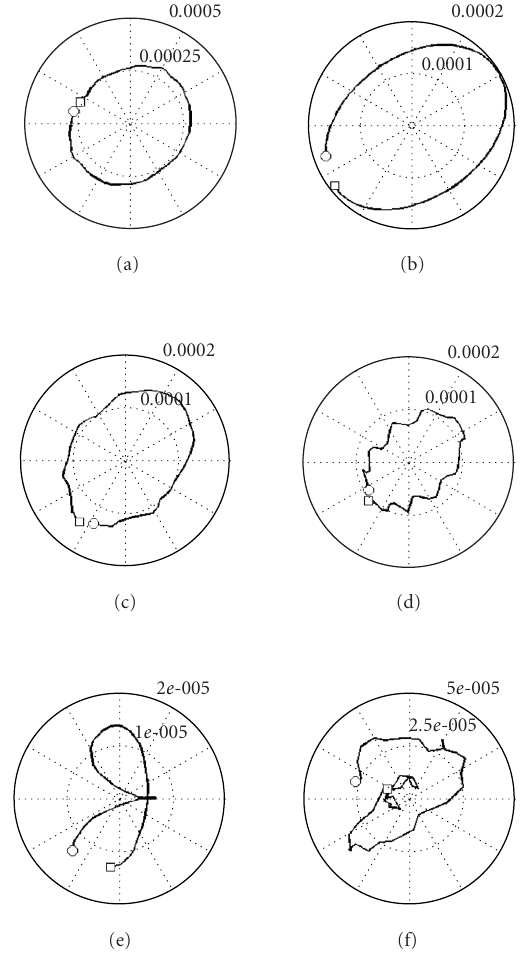
Figure 10: The orbits of the rotor at di ff erent measured planes at the first forward critical speed: (a) A 1, (b) B 1, (c) A 2, (d) A 3, (e) B 2, and (f) A 4.